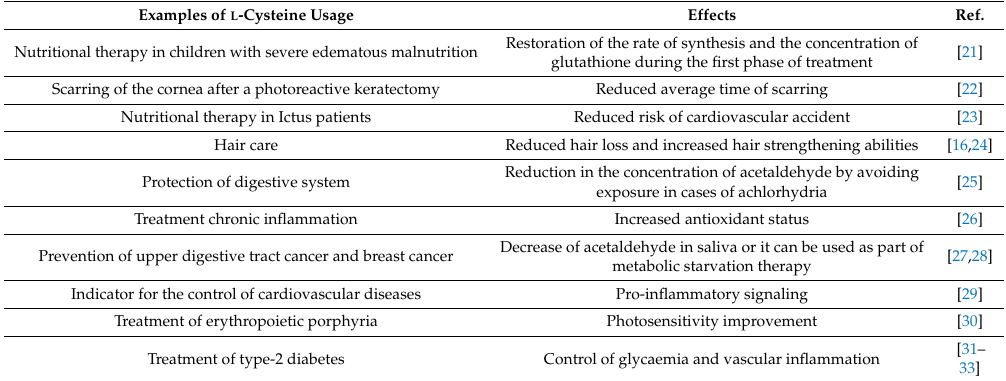
Table 2. Summary of the potential effects of L -Cys (alone) supported by studies based on clinical trials.